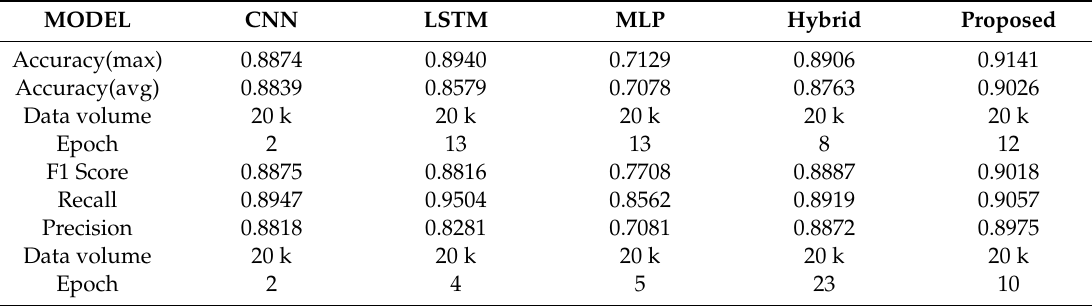
Table 3. Experimental results according to optimal accuracy, F1 score.